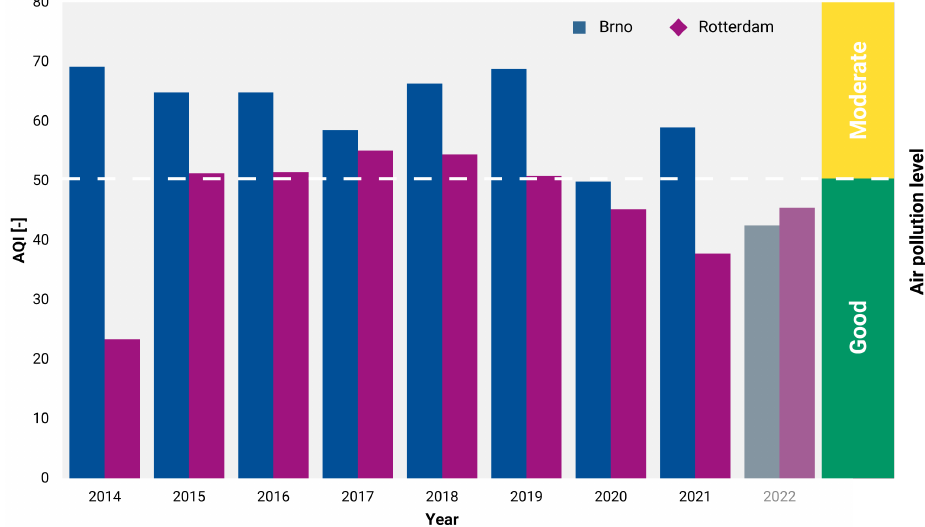
Figure 8. Year average overall Air Quality Index (AQI) for the city centre of Brno and Rotterdam.